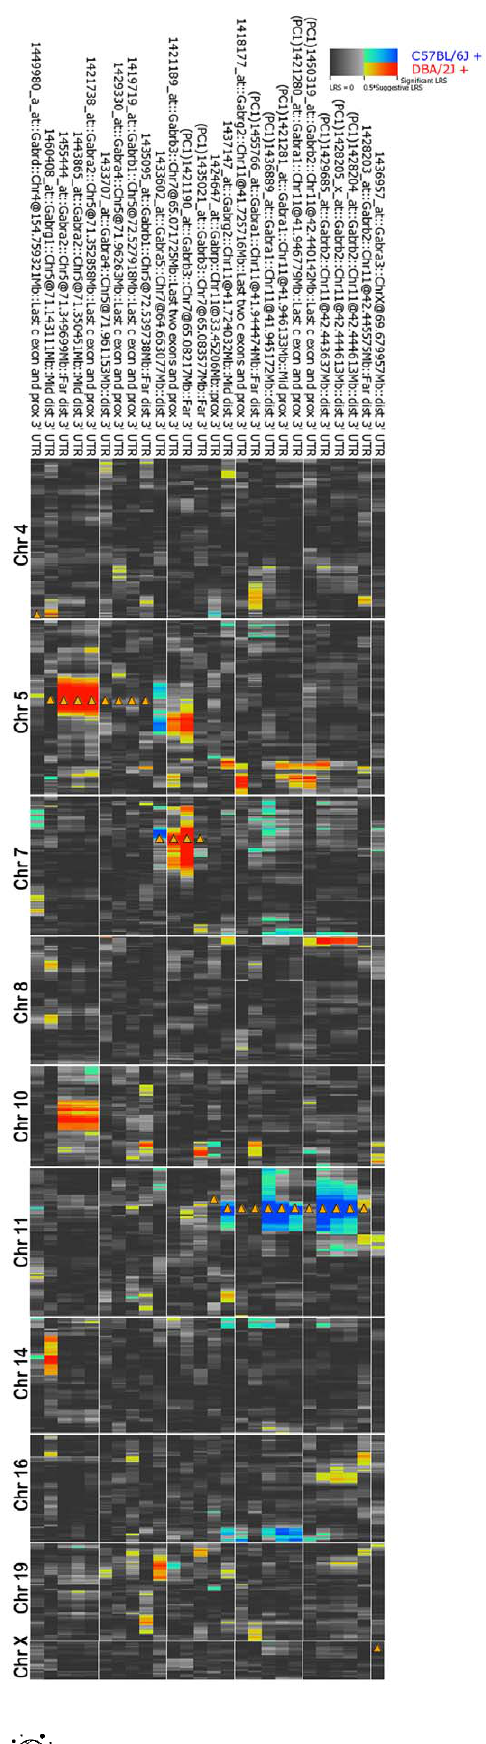
Figure 1. Summary of significant genetic regulation in the hippocampus. Probe sets represent columns and ascending genomic location for each chromosome represent rows. Only chromosomes with a significant QTL (LRS . 15) are shown. Several GABA(A)R subunits are regulated by both cis and trans eQTL ( Gabra1 , Gabra2 , Gabrb2 , and Gabrb3 ) whereas some are modified exclusively in trans ( Gabra5 , Gabrg1 ). Hue intensity provides an indication of the strength of the association between gene expression and genomic location. Red and blue alleles indicate that the D or B allele increases trait values, respectively. Arrowheads show the location of each cognate gene. PC1=first principal component, Chr=Chromosome, Mb=Megabase, Prox=proximal, mid=middle,